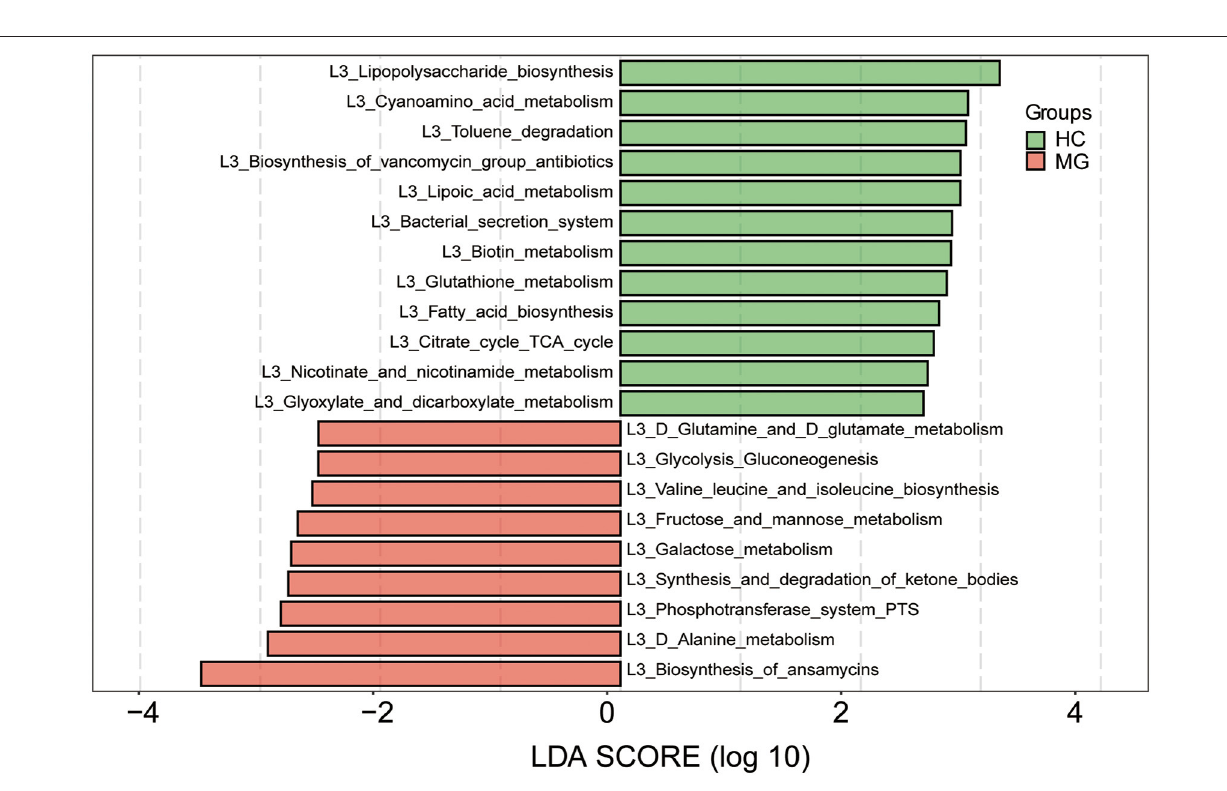
FIGURE 5 | Functional analysis of predicted metagenomes. 16S sequencing data were used for function prediction based on KEGG Pathway databases (level 3), and LEfSe analysis was performed to selectmetabolic pathways (L3 level) with significant differences between MG (red) and HC (green) groups. LDA scores on a log 10 scale are shown at the bottom. The significance of a microbial marker increased with LDA